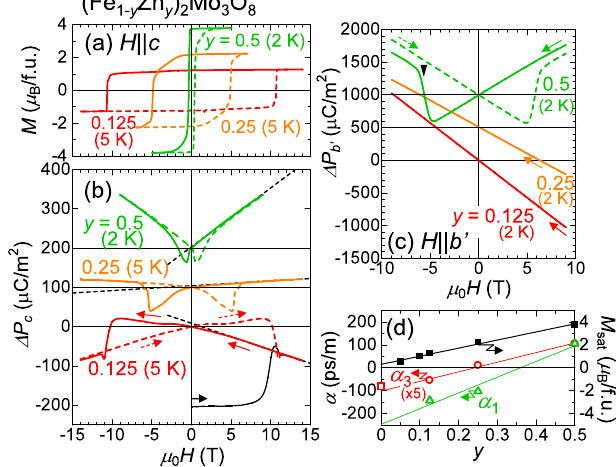
FIG. 5. (a – c) H dependence of (a) M , (b) Δ P along the c axis under H ∥ c , and (c) Δ P along the b 0 axis under H ∥ b 0 . The b 0 axis is the axis intersecting at a right angle with one of the a axes and the c axis. The colored solid and dashed curves for each y indicate the scans for þ H → − H and − H → þ H , respectively. The black solid curve for y ¼ 0 . 125 in (b) is the scan from μ 0 H ¼ 0 T to 14 T after the cooling without a field. Data of Δ P for each y are shifted for clarity. Black dashed lines are linear fits to P - H curves. (d) y dependence of ME coefficients α 1 and α 3 measured at 2 K, and saturated magnetization estimated from data in Figs. 4(c) – 4(e) and Fig. 5(a). Solid lines are linear fits. The open square indicates the value of α 3 for Fe 2 Mo 3 O 8 at 45 K, obtained from the data in Fig.